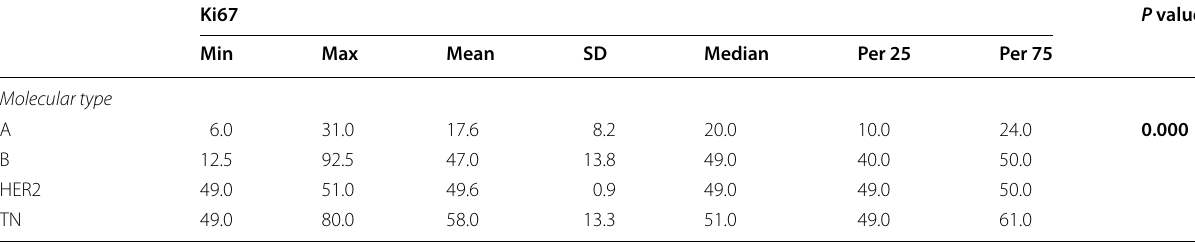
Table 8 Comparison of Ki67 regarding molecular type